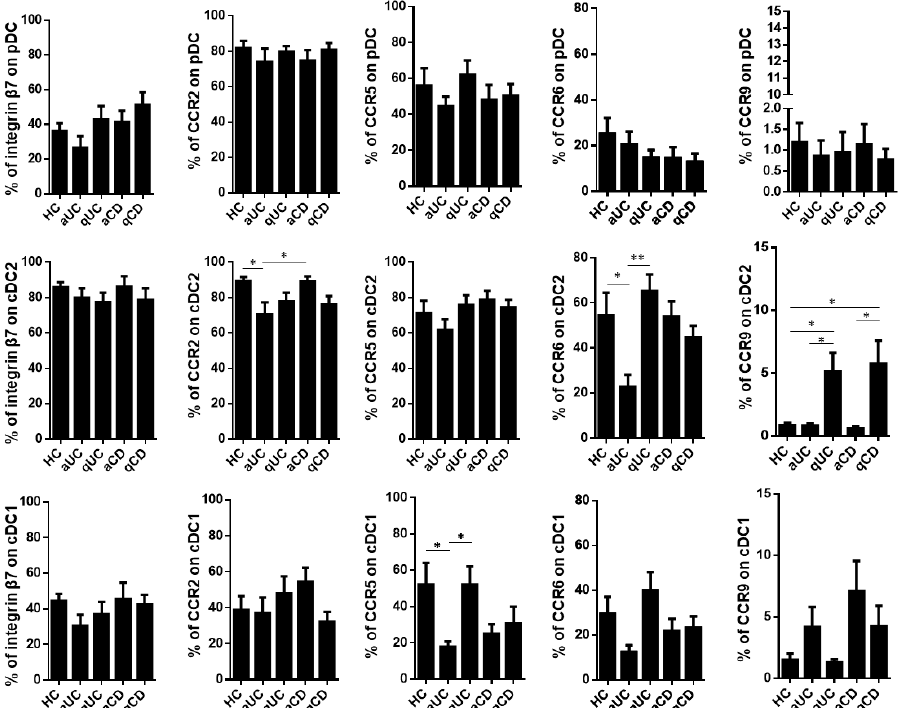
Figure 2. Integrin β7, CCR2, CCR5, CCR6 and CCR9 expression s on circulating dendritic cells from